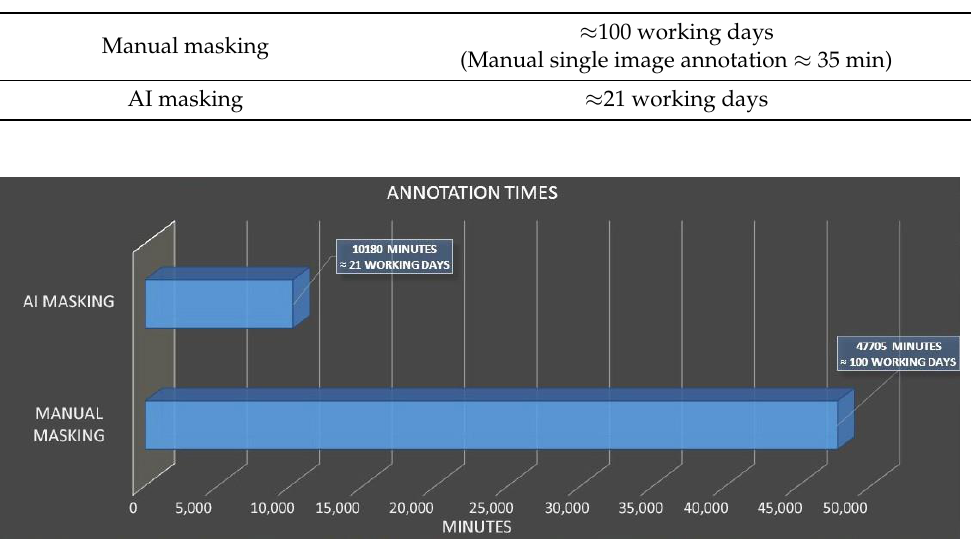
Figure 30. Comparison between the manual and AI masking times.